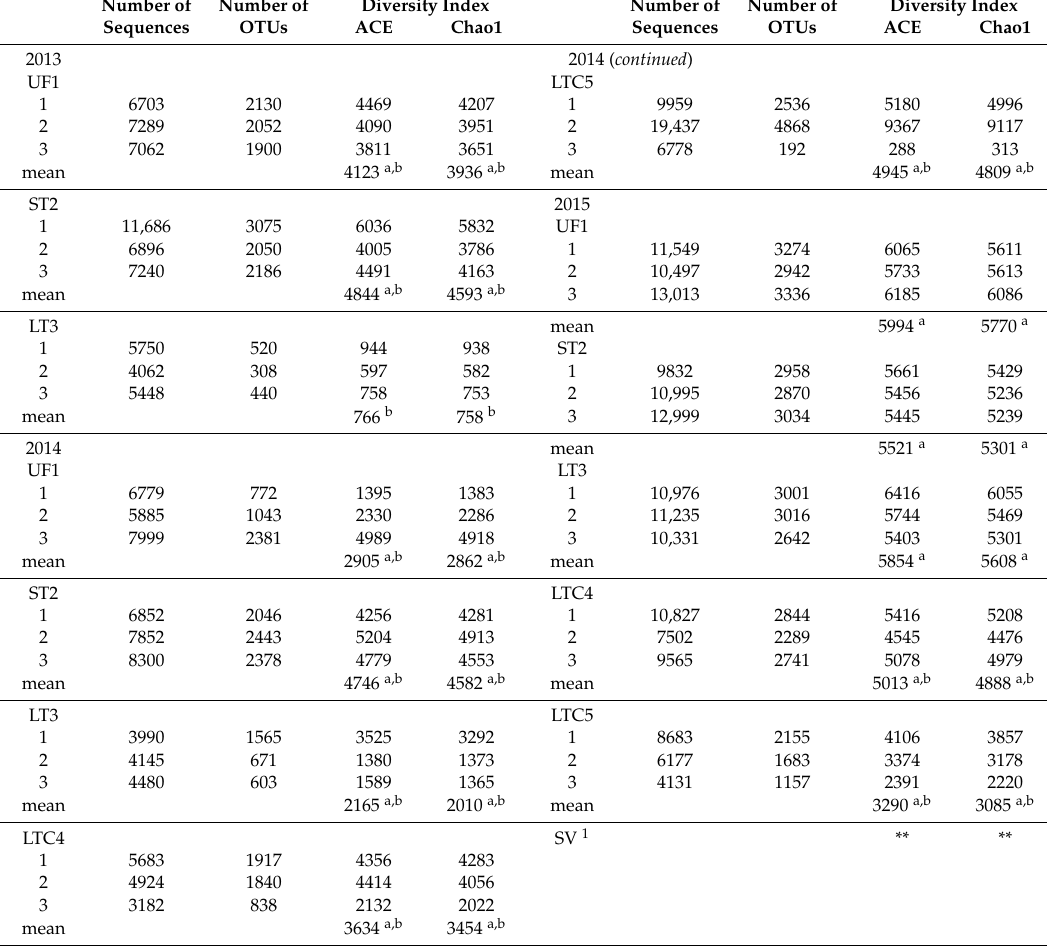
Table 3. Number of sequences, number of operational taxonomic units (OTUs), and diversity indices for soil